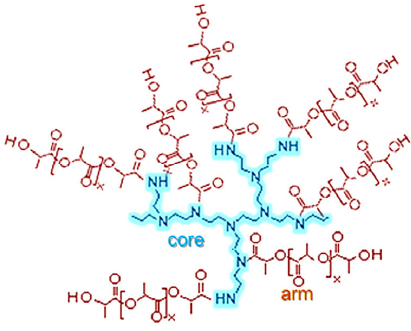
Figure 1. Scheme of multiarm star copolymers PEI x -PLA y .